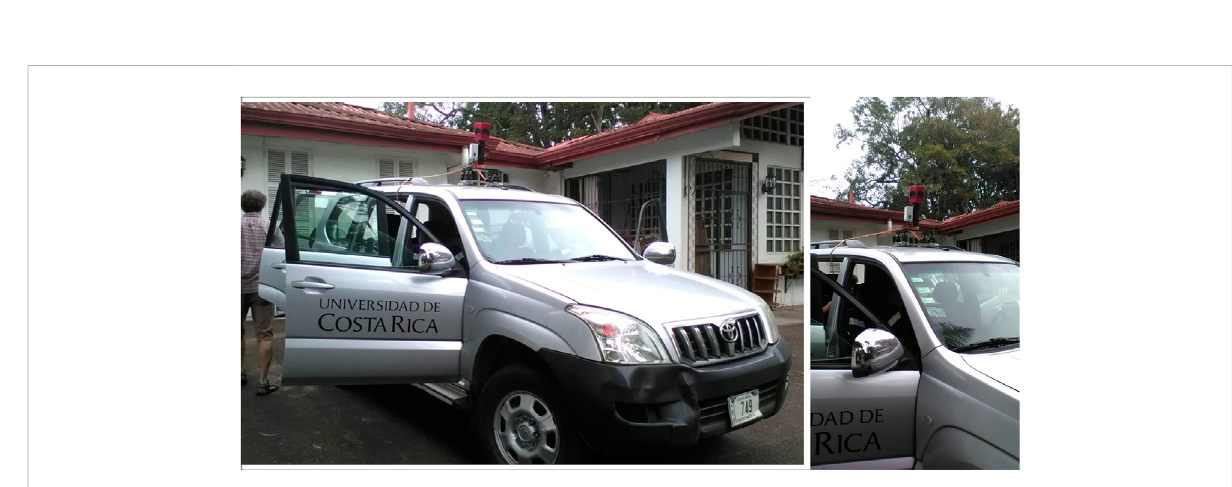
FIGURE 2 GFZ-MOMA system mounted in the vehicle for the visual data collecting